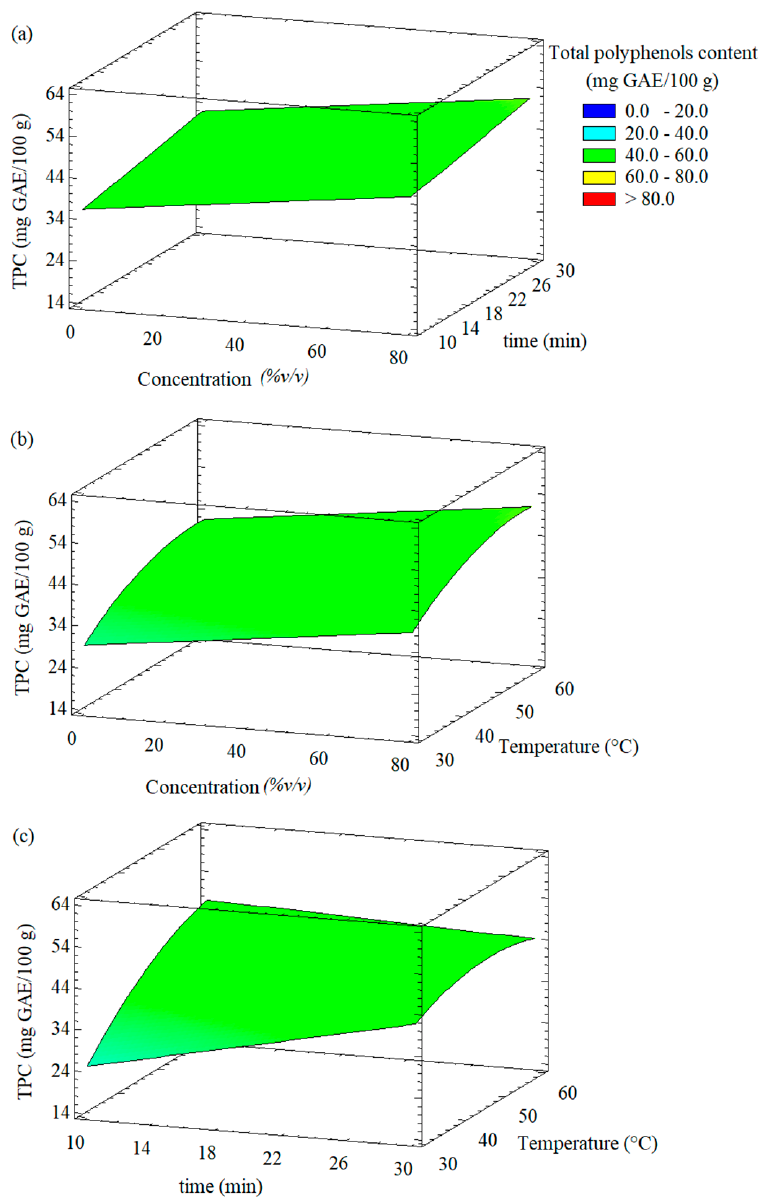
Figure 3. Response surface plots showing the effect of different experimental factors on the total polyphenols content (TPC) of the extracts from Welsh onion leaves: ( a ) effect of ethanol concentration and time; ( b ) effect of ethanol concentration and extraction temperature; ( c ) effect of time and extraction temperature.